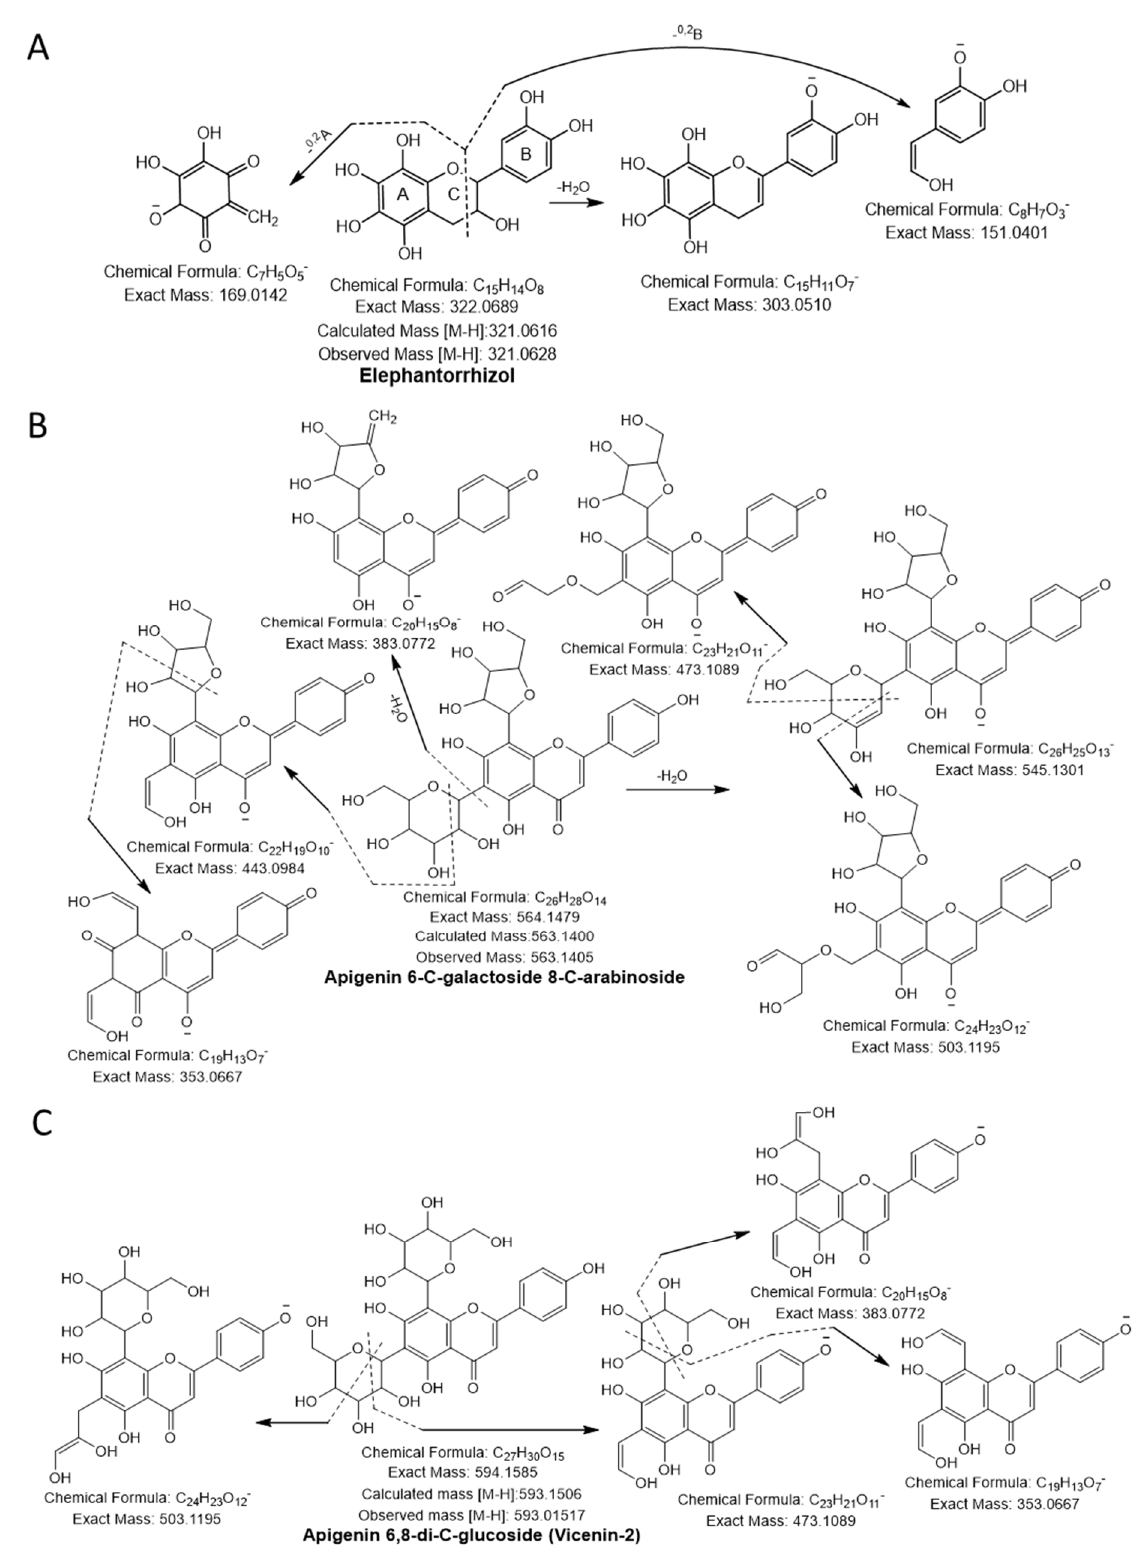
Figure 2. Flavonoids ( A ) elephantorrhizol, ( B ) apigenin 6-C-galactoside 8-C-arabinoside, ( C ) apigenin 6,8-di-C-glucoside (vicenin-2) were identified in NNSE by ESI-MS/M.